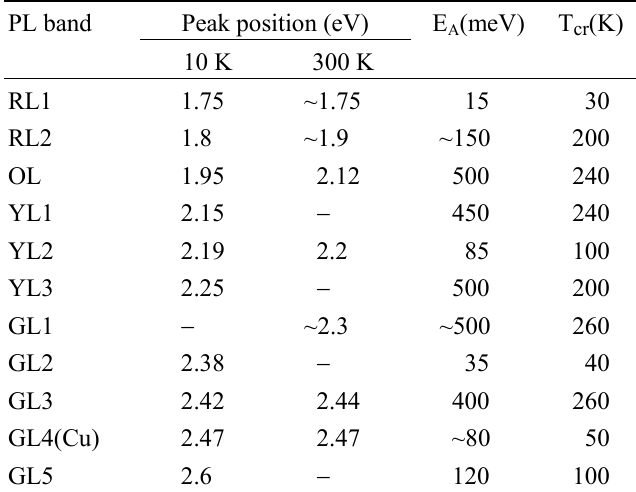
Table 2. Main characteristics of visible PL bands in ZnO. Reprinted from Ref. [66] with